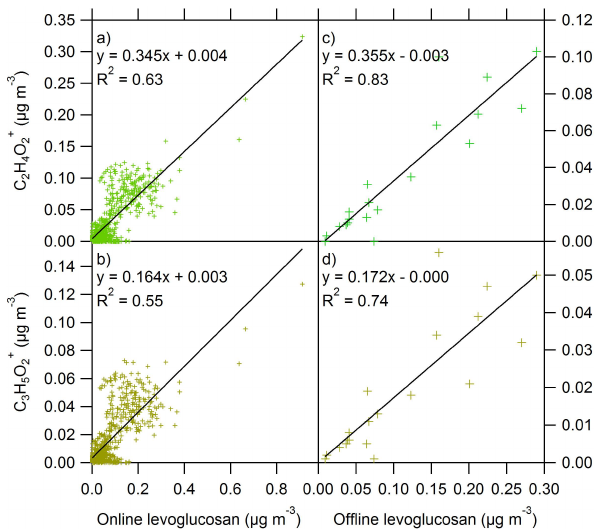
Fig. 7. Comparison of levoglucosan concentrations measured online with the PILS–HPAEC–MS and the biomass burning tracer concen- trations measured with the HR-ToF-AMS (the data were averaged with 1h time resolution) (a–b) ; and the comparison of levoglucosan concentrations determined offline from the filter samples with the HPAEC–MS and the biomass burning tracer concentrations mea- sured with the HR-ToF-AMS (the HR-ToF-AMS data were aver- aged according to the filter sampling times) (c–d) .